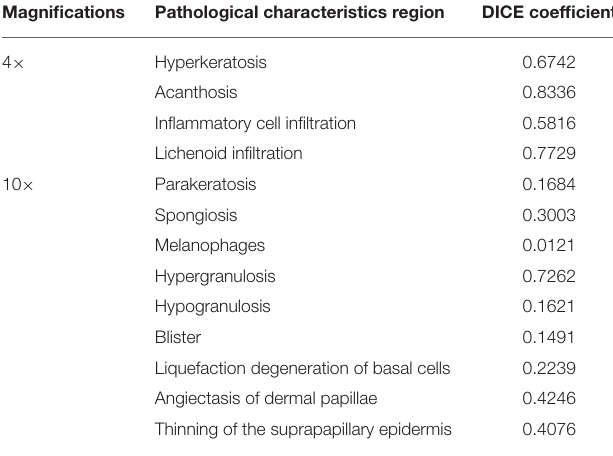
TABLE 5 | Results of pathological characteristics